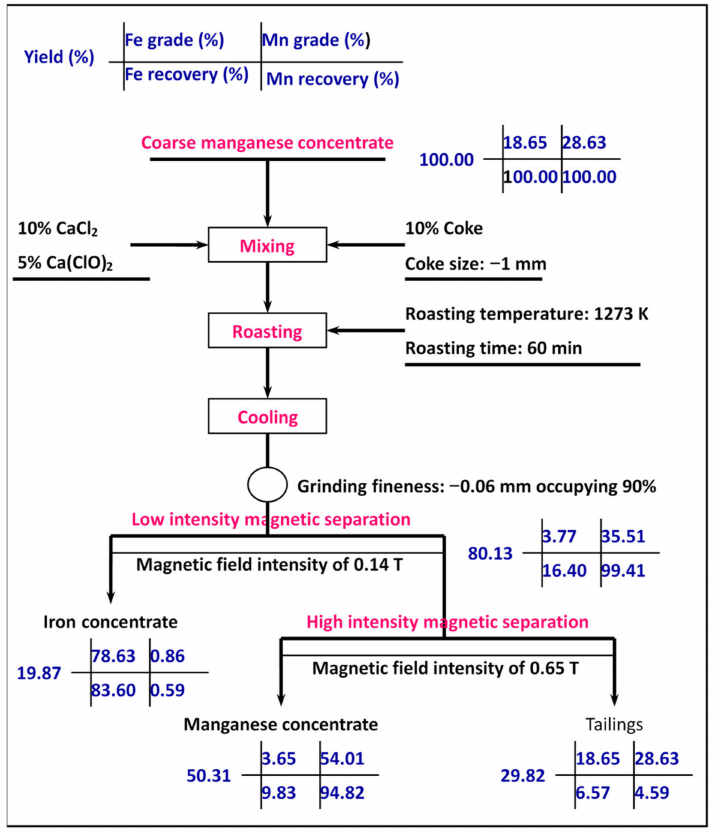
Figure 7. Scale-up test results of iron and manganese extraction from the coarse manganese concen- trate (%).